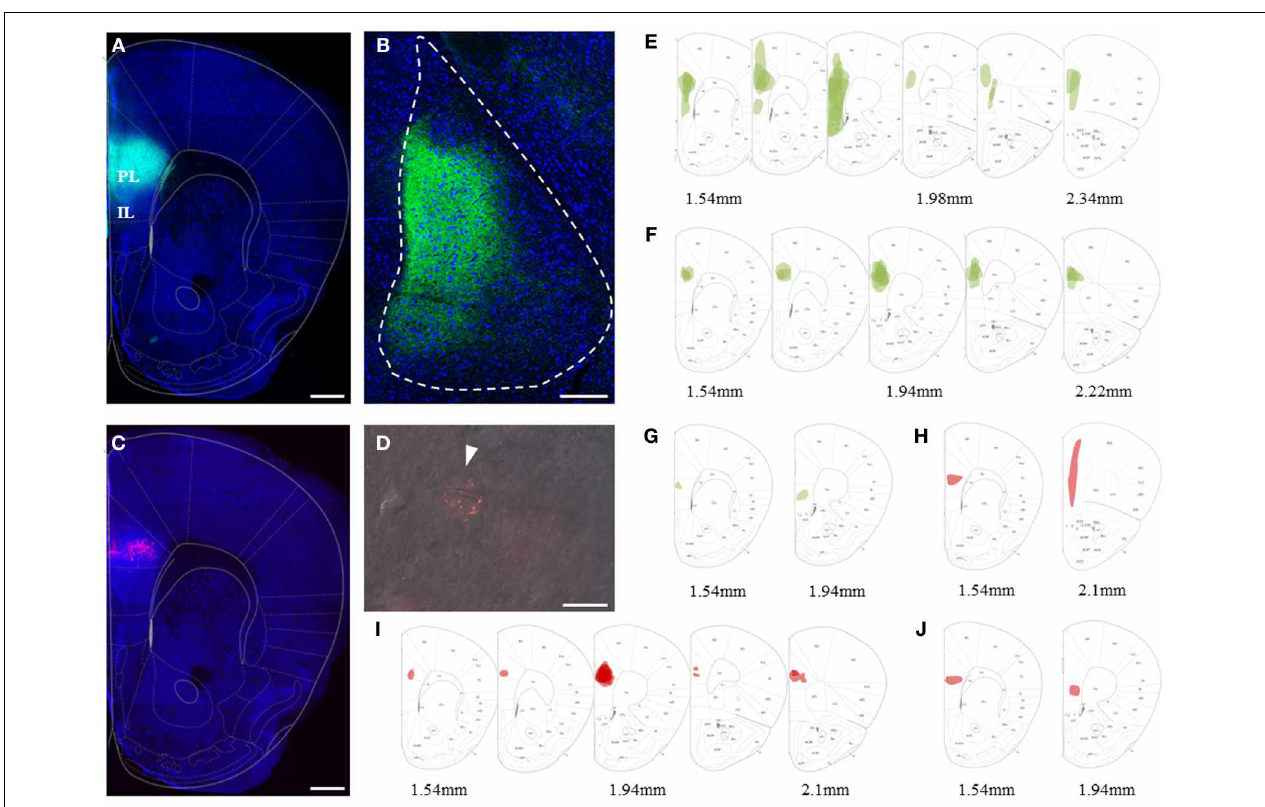
FIGURE 1 | Viral and bead injection sites for studying mPFC inputs to BLA. (A) Confocal image of a representative brain slice of an animal injected in the mPFC with rAAV-ChR2(H134R)-eYFP (green). Scale bar: 500 μ m. (B) Confocal image of a 35 ◦ tilted horizontal brain slice of the BLA with mPFC projections (green) corresponding to the injection site of (A) . Scale bar: 250 μ m. (C) Confocal image of a representative brain slice with retrobead injection site restricted to the PL region of the mPFC